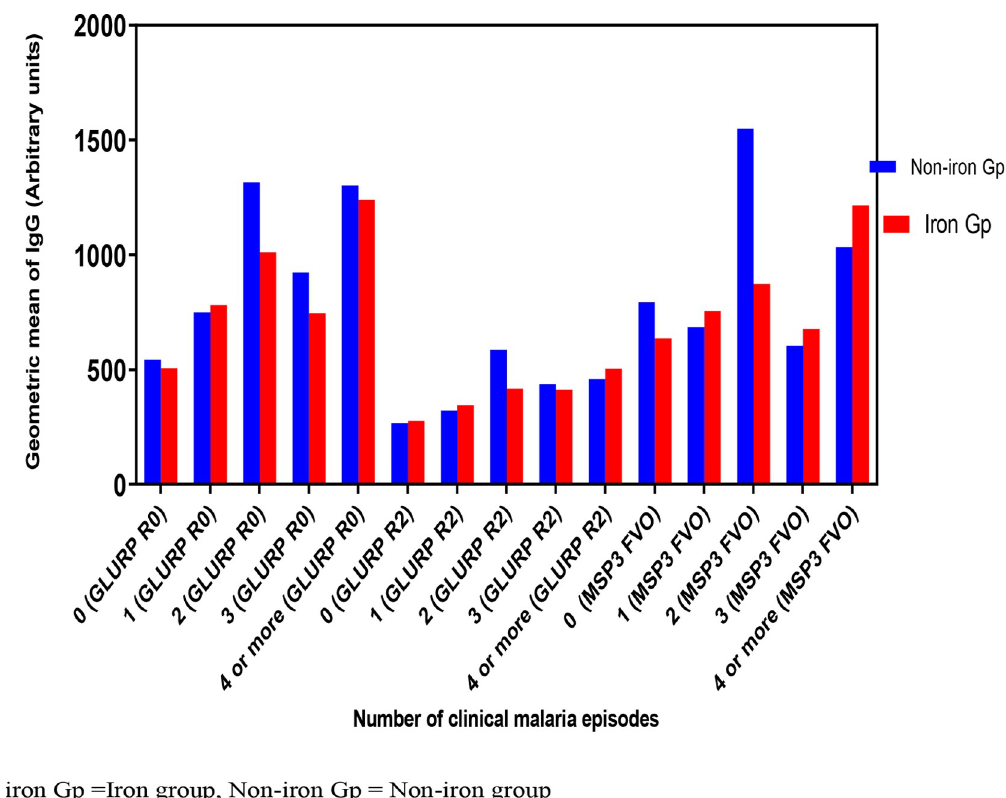
Fig 2. Antigen-specific IgG responses on the number of malaria